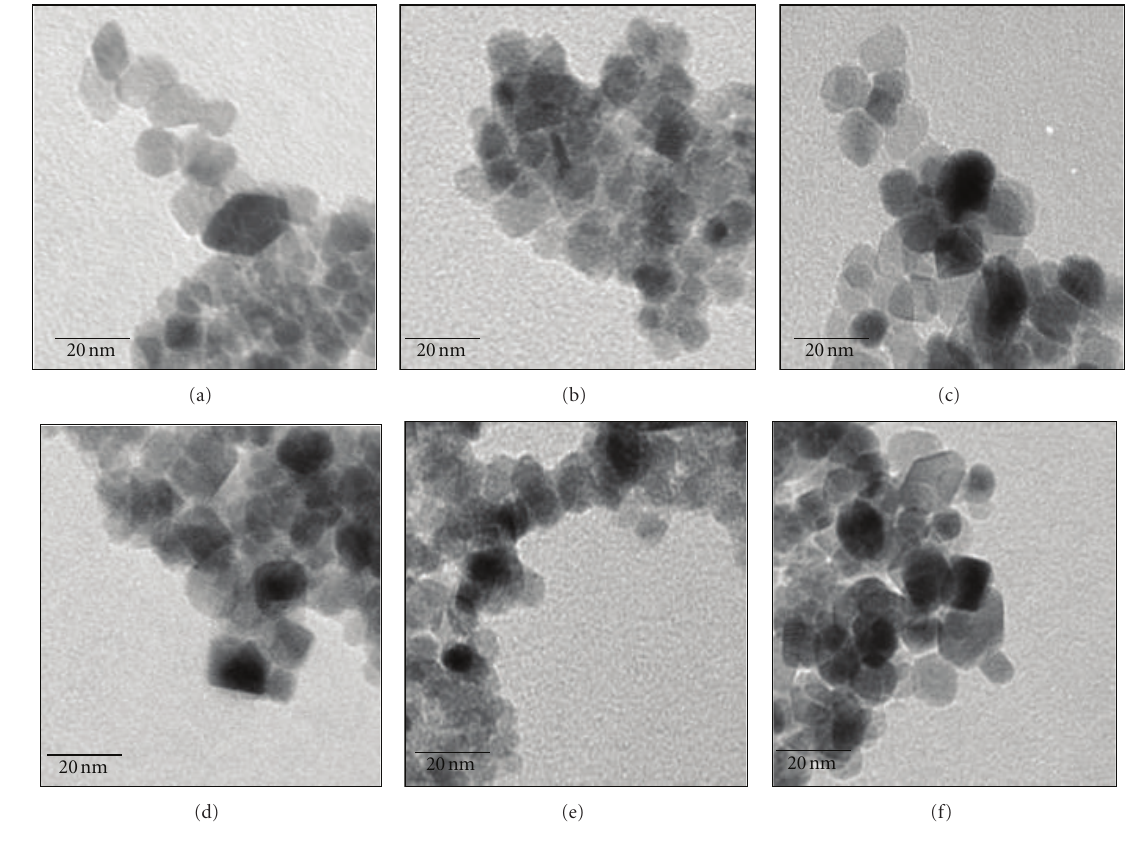
Figure 4: The TEM images of six photocatalysts as-synthesized. Table 1: The atomic composition of the six